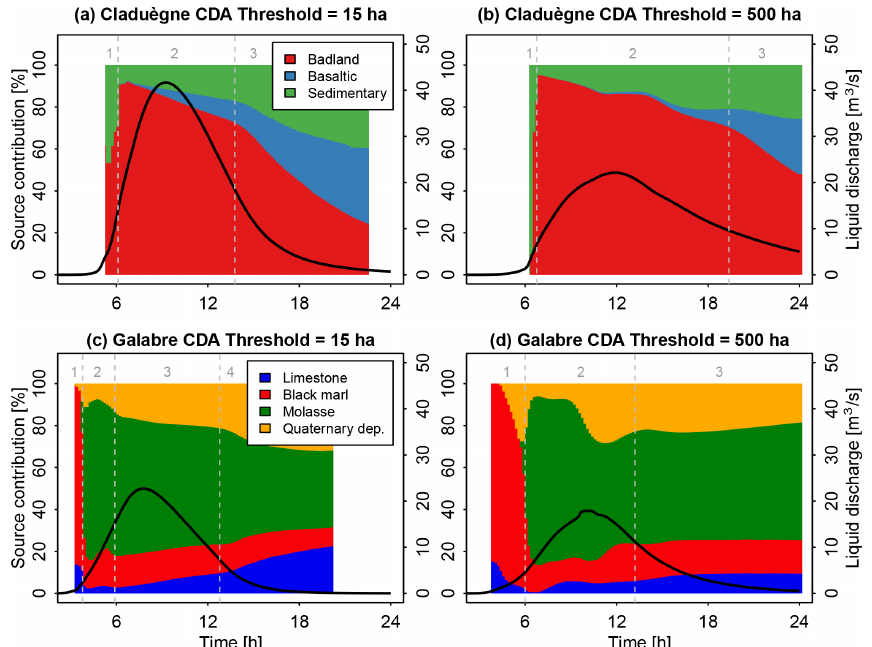
Figure 7. Modeled source contributions of the sediment sources in the Claduègne and Galabre catchments when the threshold of contributing drainage area (CDA) is set to 15ha ( a and c , Sc. 1) or to 500ha ( b and d , Sc. 2d). The color shows the contribution of the different sources to total suspended sediment load in percent. The hydrograph is additionally shown to represent the timing of the event. The results obtained with all five CDA thresholds (15, 35, 50, 150, and 500ha) for both catchments can be visualized in interactive figures at https: //shiny.osug.fr/app/EROSION_MODEL.2020 (last access: 2 March 2021).